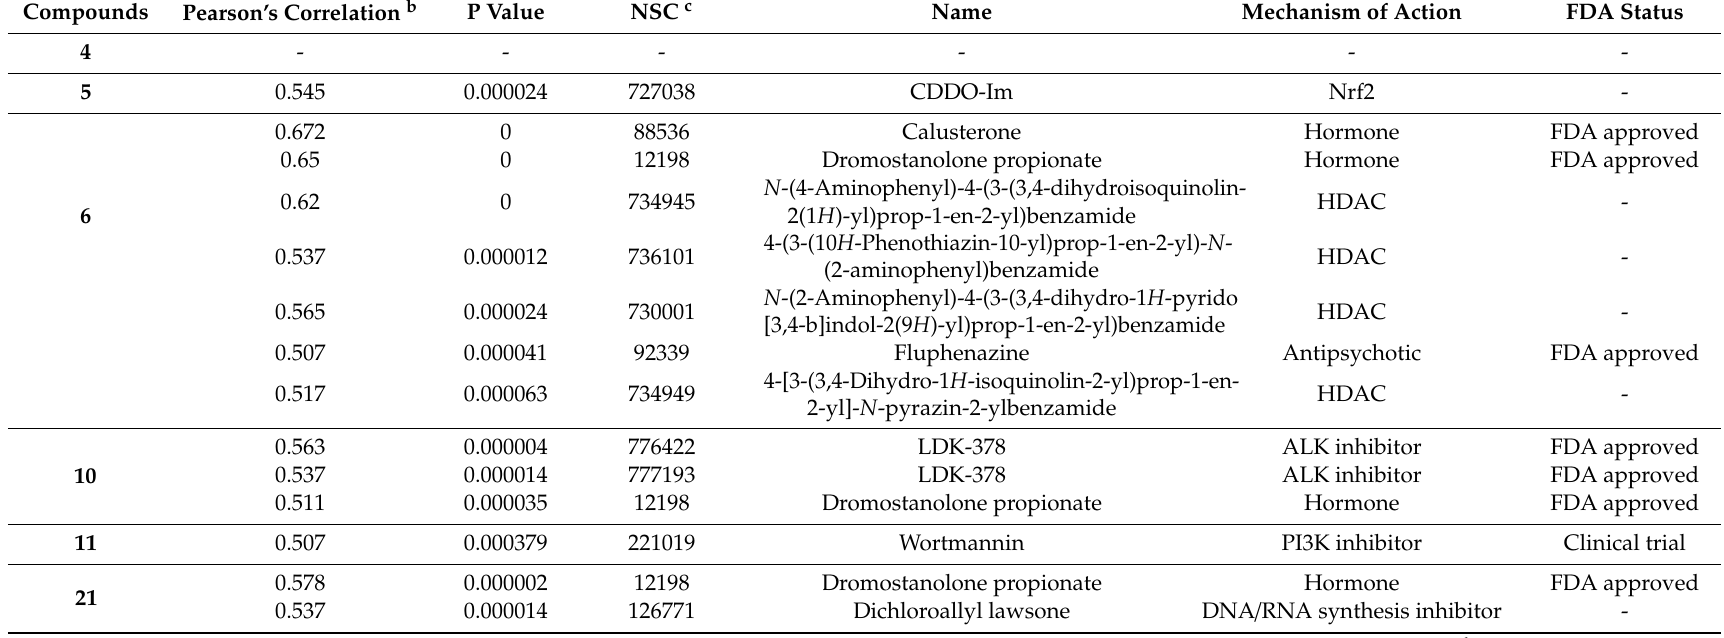
Table 5. Possible mechanism of action for the lead compounds according to CellMiner a